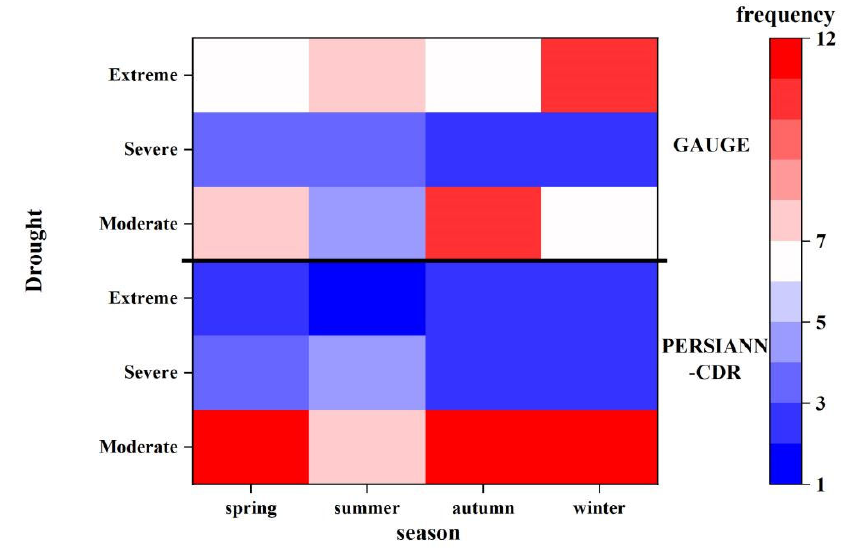
Figure 16. The thermodynamic diagram of drought events derived from the two precipitation data sets.